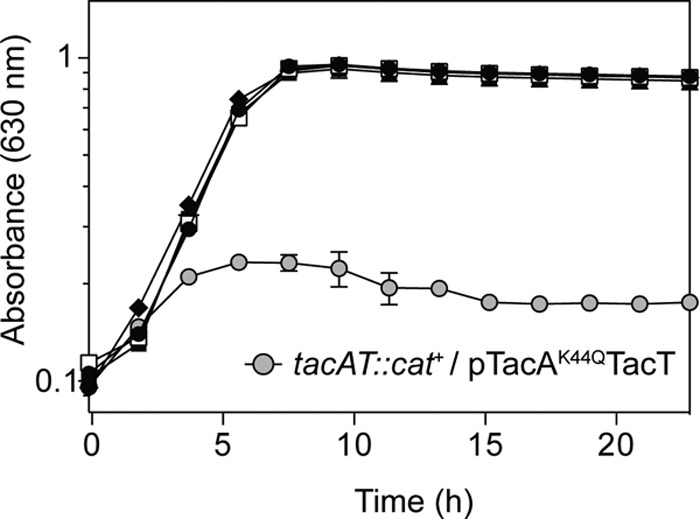
TacA variant mimicking acetylation in complex with TacT in S. enterica tacAT::cat+ strains causes growth defect. Genes coding for TacTWT (pTacT), TacATWT (pTacATWT), TacAK44RTWT (pTacAK44RTacTWT), and TacAK544QTWT (pTacAK44QTacTWT) were cloned into a complementation vector (pCV1) and introduced into the strain backgrounds indicated by the following symbols: tacAT::cat+/pCV1 (empty cloning vector control), solid circles; tacAT::cat+/pTacTWT, open squares; tacAT::cat+/pTacATWT, solid squares; tacAT::cat+/pTacAK44RTWT, diamonds; tacAT::cat+/pTacAK44QTWT, gray circles. Overnight cultures were grown in NB rich medium. Cells were subcultured (1% [vol/vol]) and grown in NCE minimal medium supplemented with glycerol (22 mM) and ampicillin. Expression of plasmid-borne genes was induced with 25 μM l-(+)-arabinose. Growth curves were obtained in technical triplicates of biological triplicates, and analyses were repeated three times using a microplate reader (Biotek Instruments). Error bars represent standard deviations from technical triplicates.